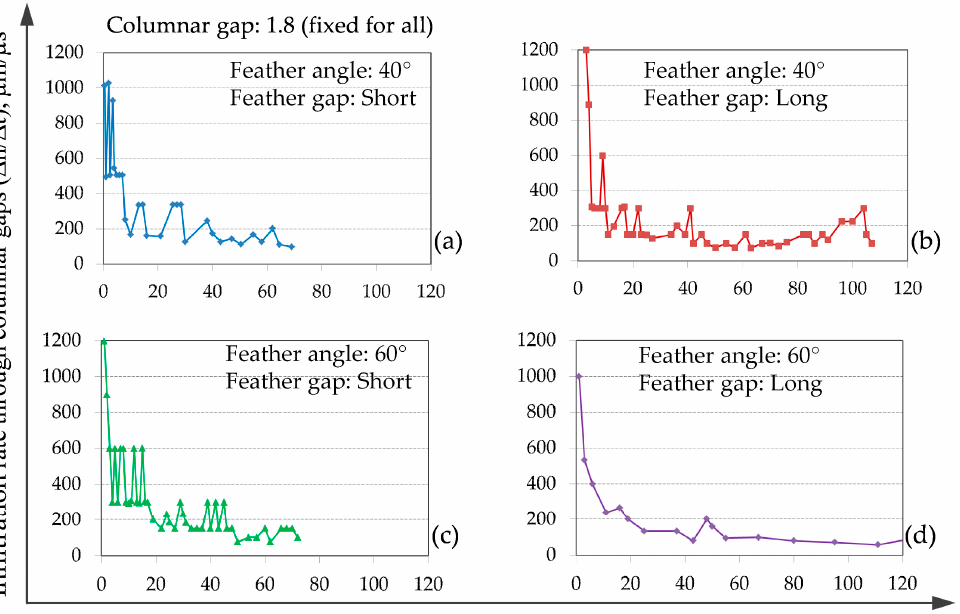
Figure 15. Change of infiltration rate through columnar gaps (vertical infiltration) influenced by different feather morphologies. The results are shown for: ( a ) short feathers with 40° feather inclination; ( b ) long feathers with 40° feather inclination; ( c ) short feathers with 60° feather inclination; and ( d ) long feathers with 60° feather inclination.